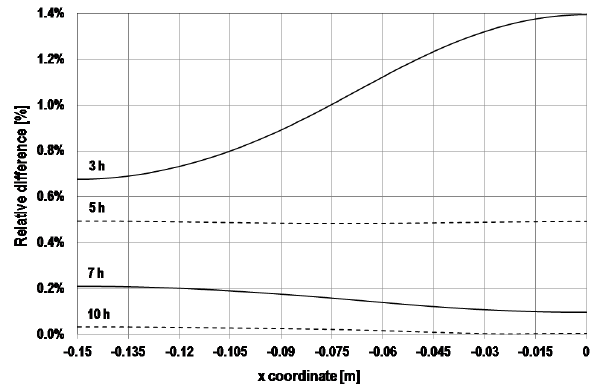
Figure 11: Relative differences between computations results ob- tained by COMSOL Multiphysics program and author’s own pro- gram. Table 2: Partition of the model of a floor heater and parameters of the system of equations.